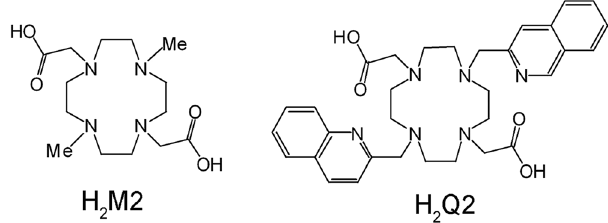
Figure 1. Drawings of H 2 M2 and H 2